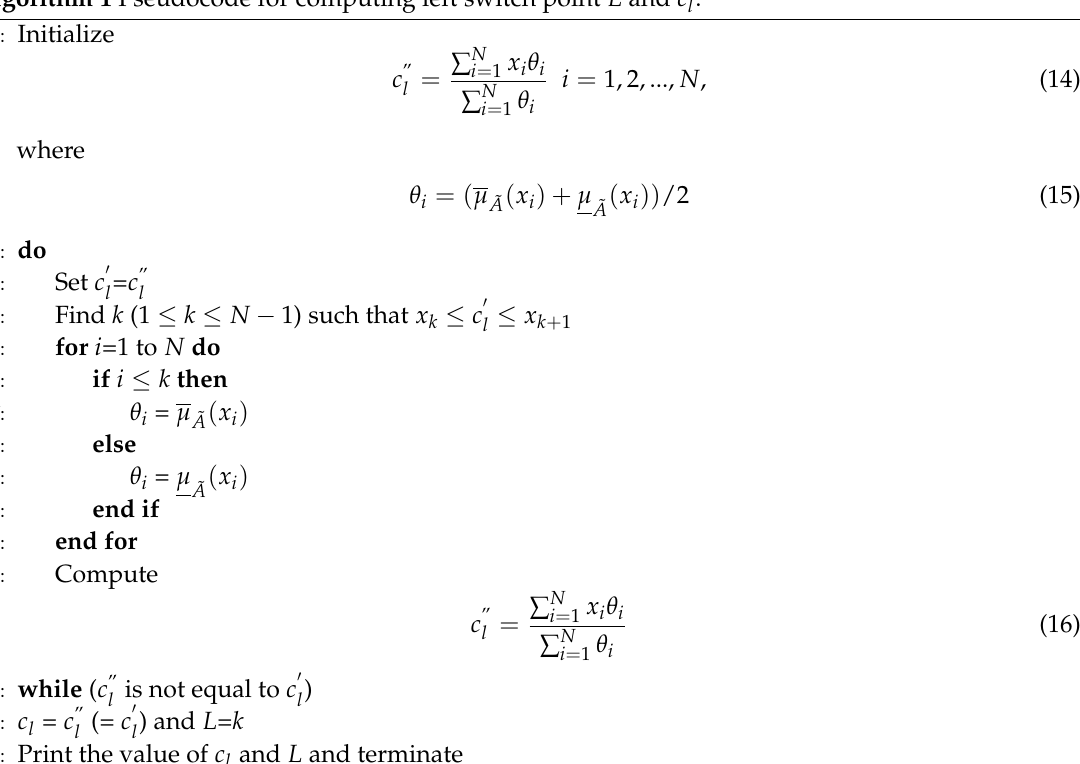
Algorithm 1 Pseudocode for computing left switch point L and c l